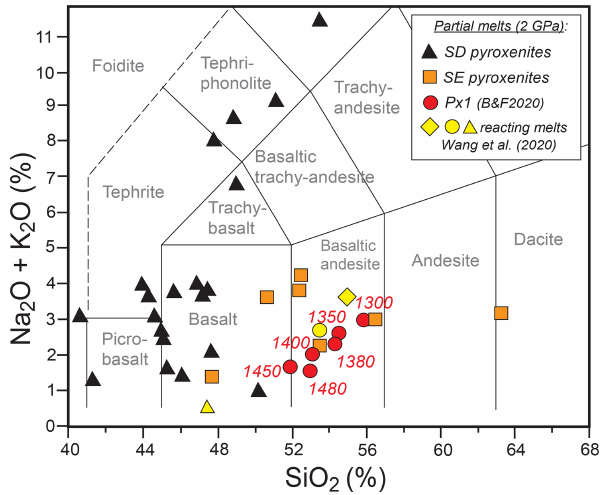
Figure 2. Total alkali versus silica (TAS) diagram showing the com- position of Px1 partial melts at 2GPa and 1300–1450 ◦ C (data from Borghini and Fumagalli, 2020). Also reported for comparison are periments by Wang et al. (2020) and from partial melting